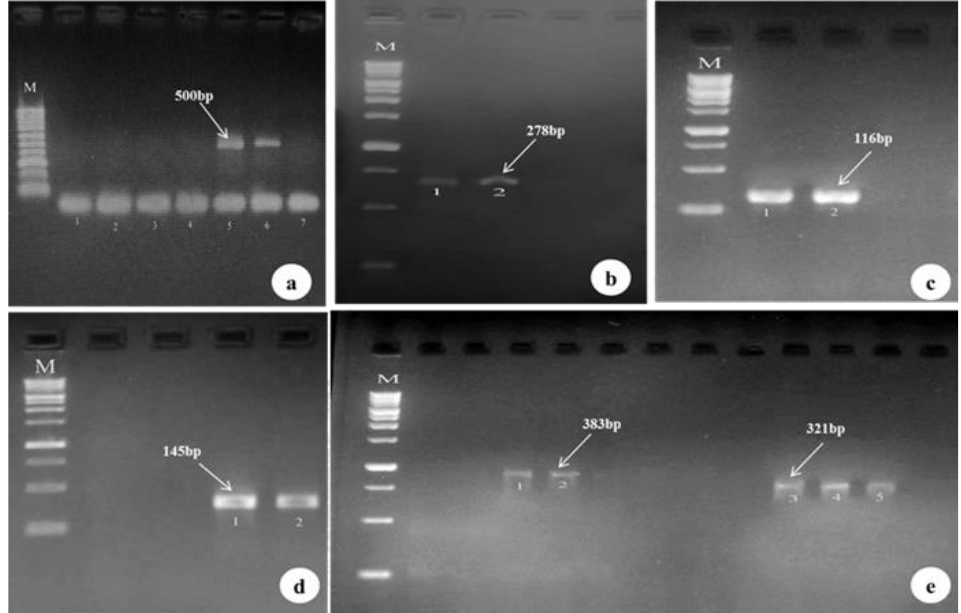
Figure 3. Results were obtained by PCR followed by 2% agarose gel electrophoresis. Lines in M show a 1000 bp DNA marker. Samples include the genus Eimeria , 500 bp ( a ), E. tenella, 278 bp ( b ), E. praecox, 116 bp ( c ), E. maxima, 145 bp ( d ), E. acervulina , 383 bp and E. necatrix, 321 bp ( e ).